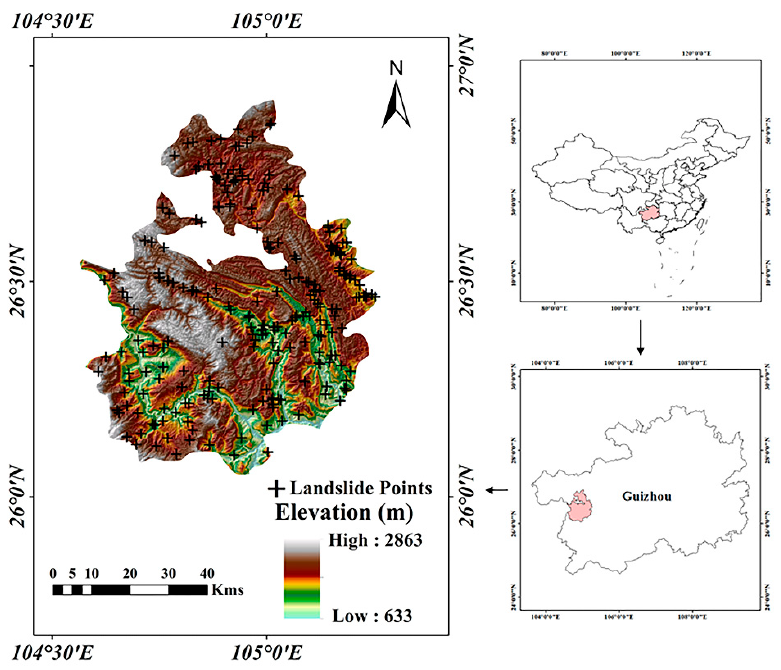
Figure 1. Location and landslide points of Shuicheng County.